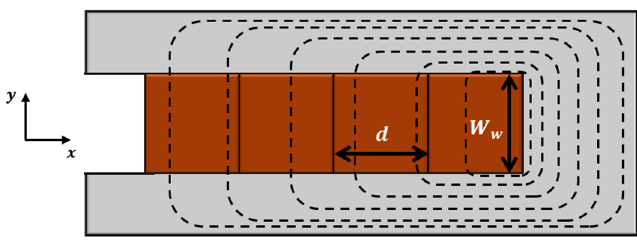
Figure 7. Slot leakage flux lines.